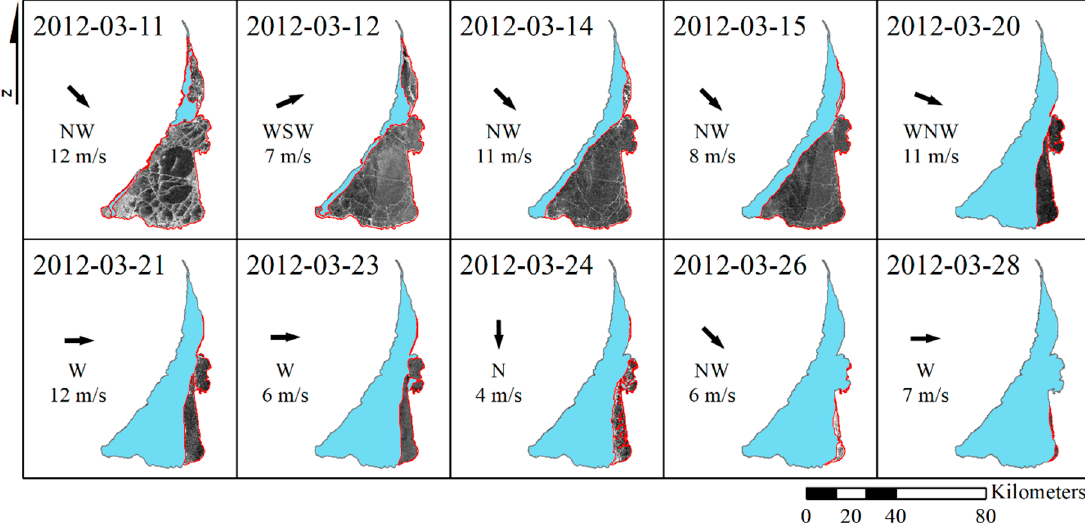
Figure 8. The ice cover retreat in the Curonian Lagoon in the winter of 2011–2012 under the prevalence of northwesterly winds. The red color indicates the ice cover boundary, the blue color shows water, the labels and arrows show the wind speed and direction.